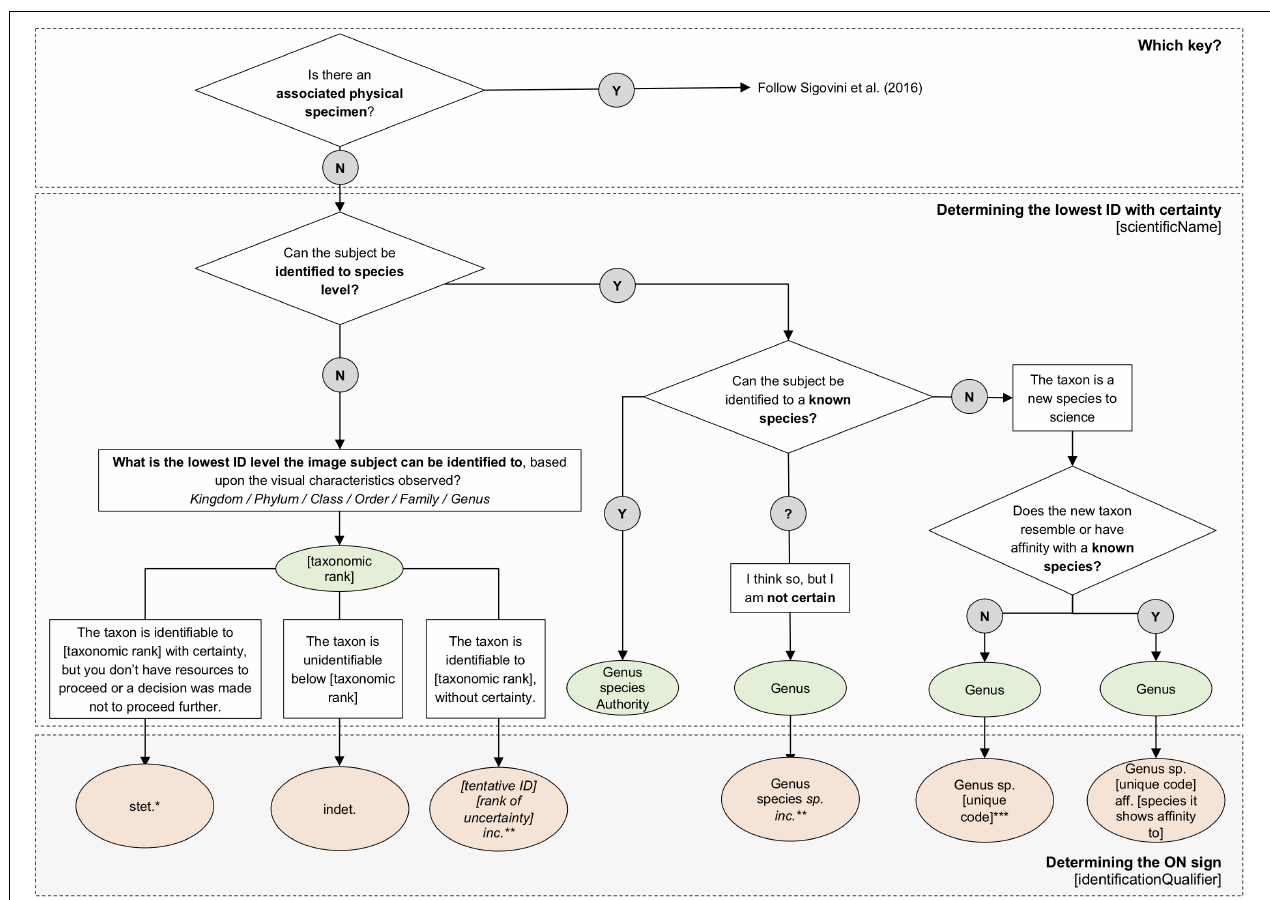
FIGURE 1 | Key steps to identification of taxa in images. The flowchart provides a means to determine the lowest rank of identification with certainty, and provides an example of the ON sign to use in each case. For each ON sign the identifier can check ( Figures 2 , 3 , 5 , 6 ) for examples formatted for output in Darwin Core terms. *There are various reasons for using stet ., which will depend on the operator applying the ON sign. The reason for stopping should be given in the identificationRemarks field, e.g., no experience of ID of this taxon (indicating it may be possible for another identifier with more experience of the group to take the identification further). ** incerta can be used at any level of the identification (phylum inc., class inc., order inc., fam. inc., gen. inc., sp. inc.). It indicates the identification is not absolutely certain and should be added after the rank of uncertainty (e.g., Brisinga gen. inc.; Brisinga costata sp. inc.) If uploading the occurrence data to GBIF/OBIS, the lowest taxonomic rank should be entered in the scientificName field and the ON sign in the identificationQualifier field. ***The use of ‘sp. nov.’ should be avoided for input to the field identificationQualifier as it is required by nomenclatural codes to explicitly indicate a new species, and may also result in non-unique identifiers. The use of a unique sequential, alphanumeric code for new taxa is recommended for entry to the identificationQualifier field (see text and examples in Figures 2 , 3 , 6 ) with further information about the new taxon held in the identificationRemarks